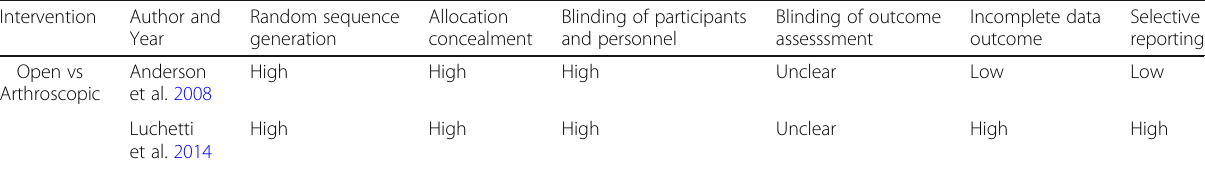
Table 3 Results of the risk of bias assessment